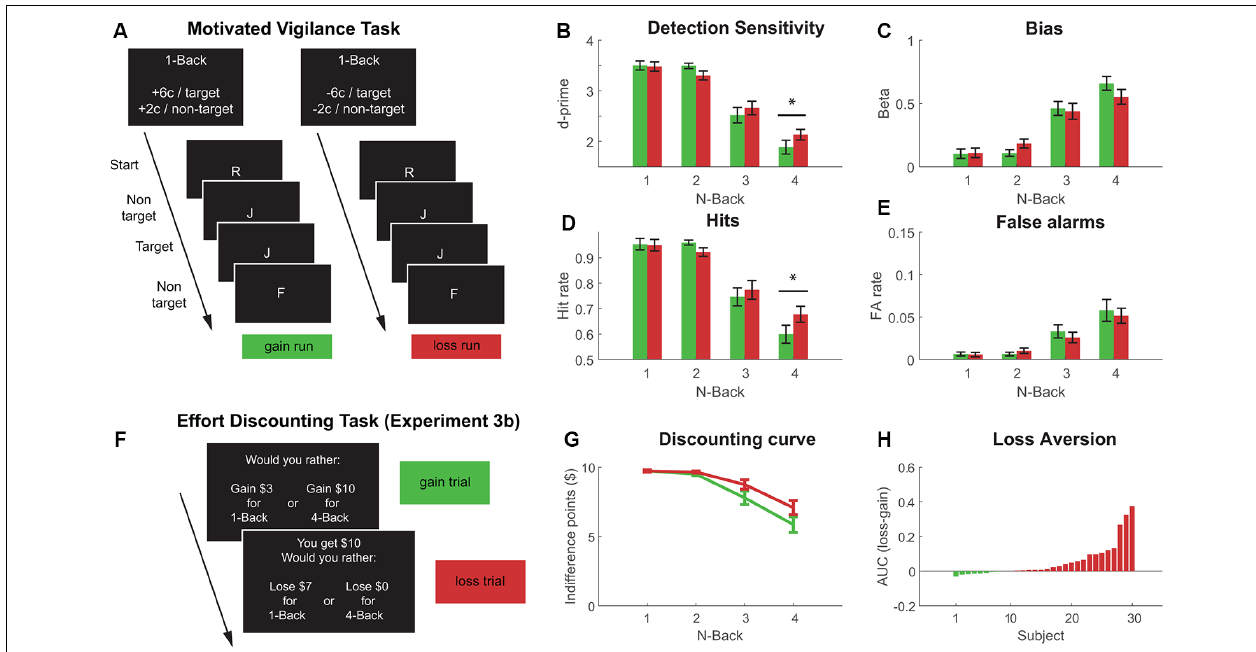
FIGURE 3 | Results from Experiments 3a and 3b with (A) schematic of the incentivized N-Back task in Experiment3a, (B) detection sensitivity (d-prime) in the N-Back task for gain and loss conditions, (C) detection bias (beta), (D) hit rate, (E) false alarm rate, (F) example trials in the Effort Discounting Task in Experiment 3b (G) effort-discounting indifference points and (H) loss-gain difference in the area under the discounting curve (AUC; positive difference scores denote less discounting for loss vs. gain choices). ∗ p <